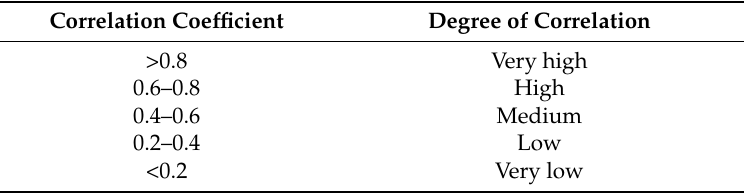
Table 4. Pearson correlation